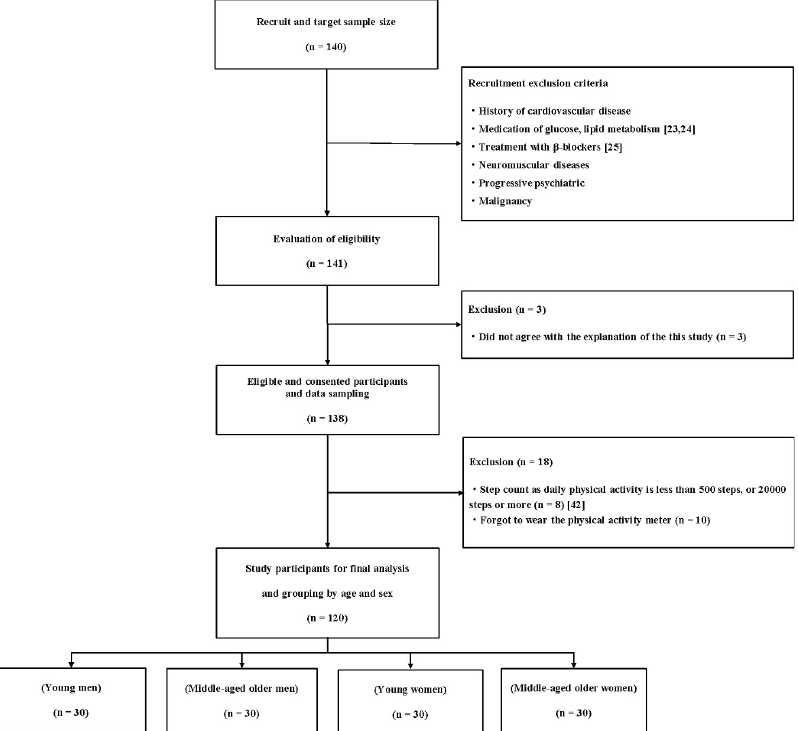
Fig 1. Study design and exclusion criteria. Individuals taking medications for lipid metabolism were excluded because they have been shown to reduce the EAT volume [23,24].Those taking antihypertensive medications were not excluded because antihypertensive medications have not been reported to affect the EAT volume. Moreover, treatment with β -blockers reduce the heart rate response during exercise; thus, individuals taking such drugs were excluded from the study